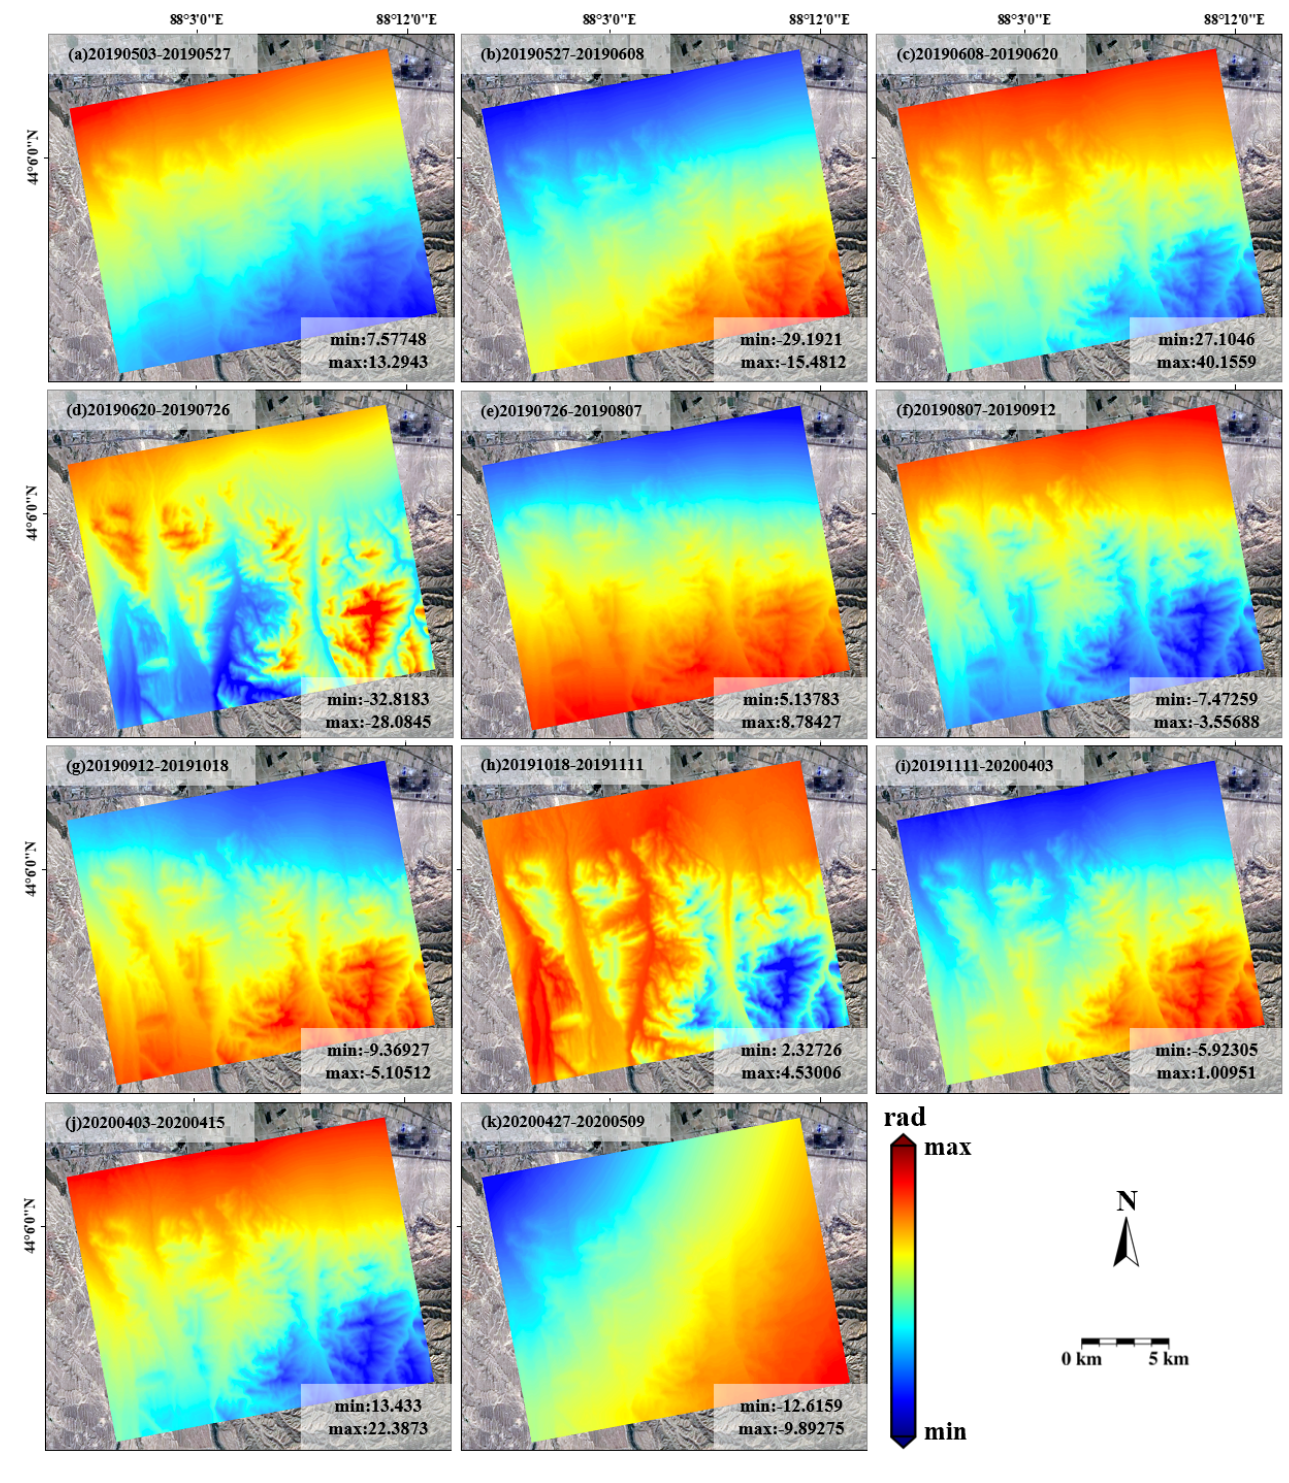
Figure 4. Atmospheric phase screen (APS) estimated by D-LOS model using ERA5. ( a – k ) Shows the estimation of APS by D-LOS model for some interferograms showing the maximum and minimum values